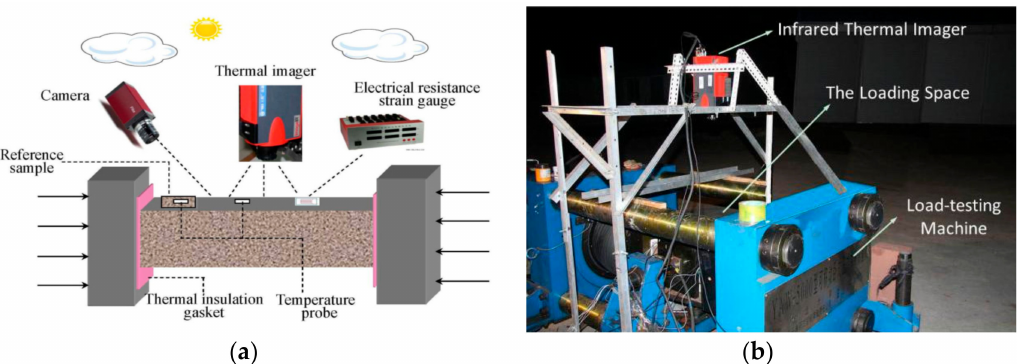
Figure 1. Experimental scene: ( a ) schematic of the instrument arrangement, ( b ) photo of the experimental system under outdoor conditions at